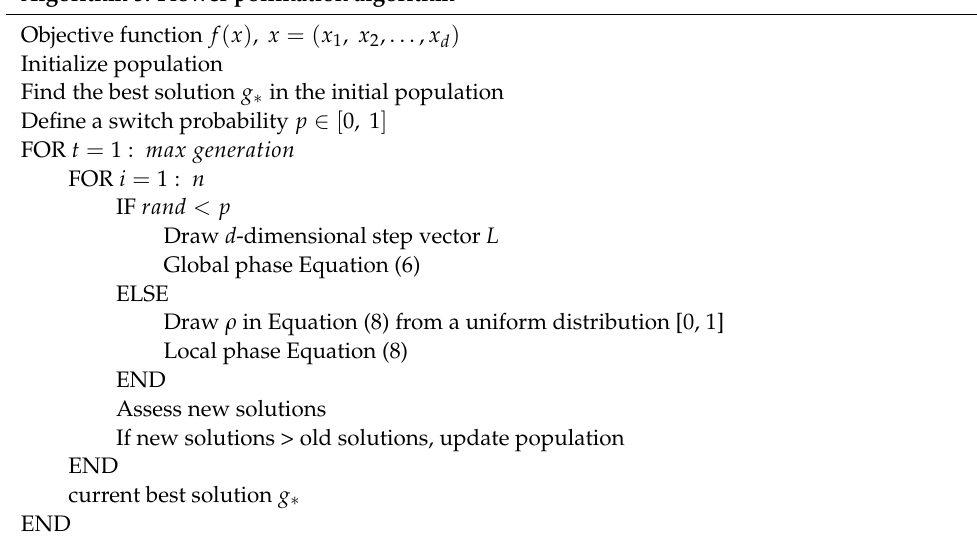
Algorithm 5: Flower pollination